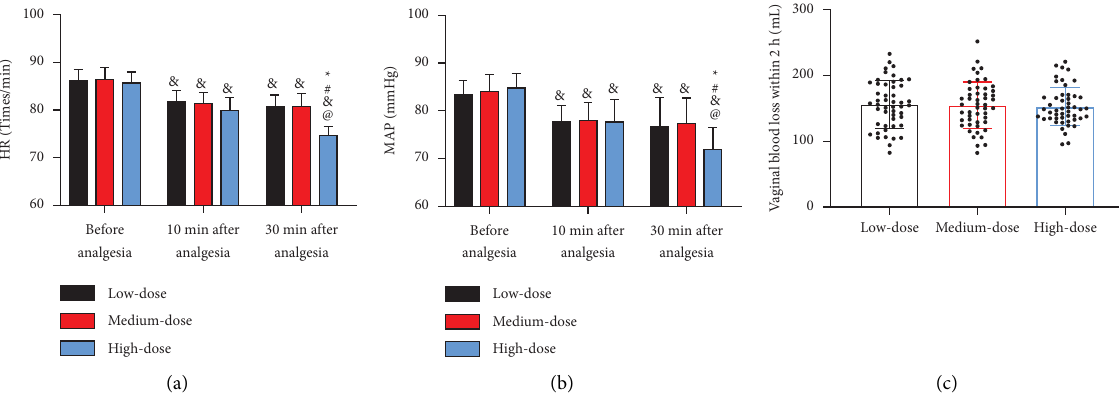
Figure 3: Comparison of hemodynamics. (a) Comparison of MAP. (b) Comparison of HR. (c) Comparison of vaginal blood loss within 2h postpartum. Note . Compared with the low-dose group, ∗ P < 0 . 05; compared with the middle-dose group, # P < 0 . 05; vs. before analgesia, & P < 0 . 05; vs. 10min after analgesia, @ P < 0 .